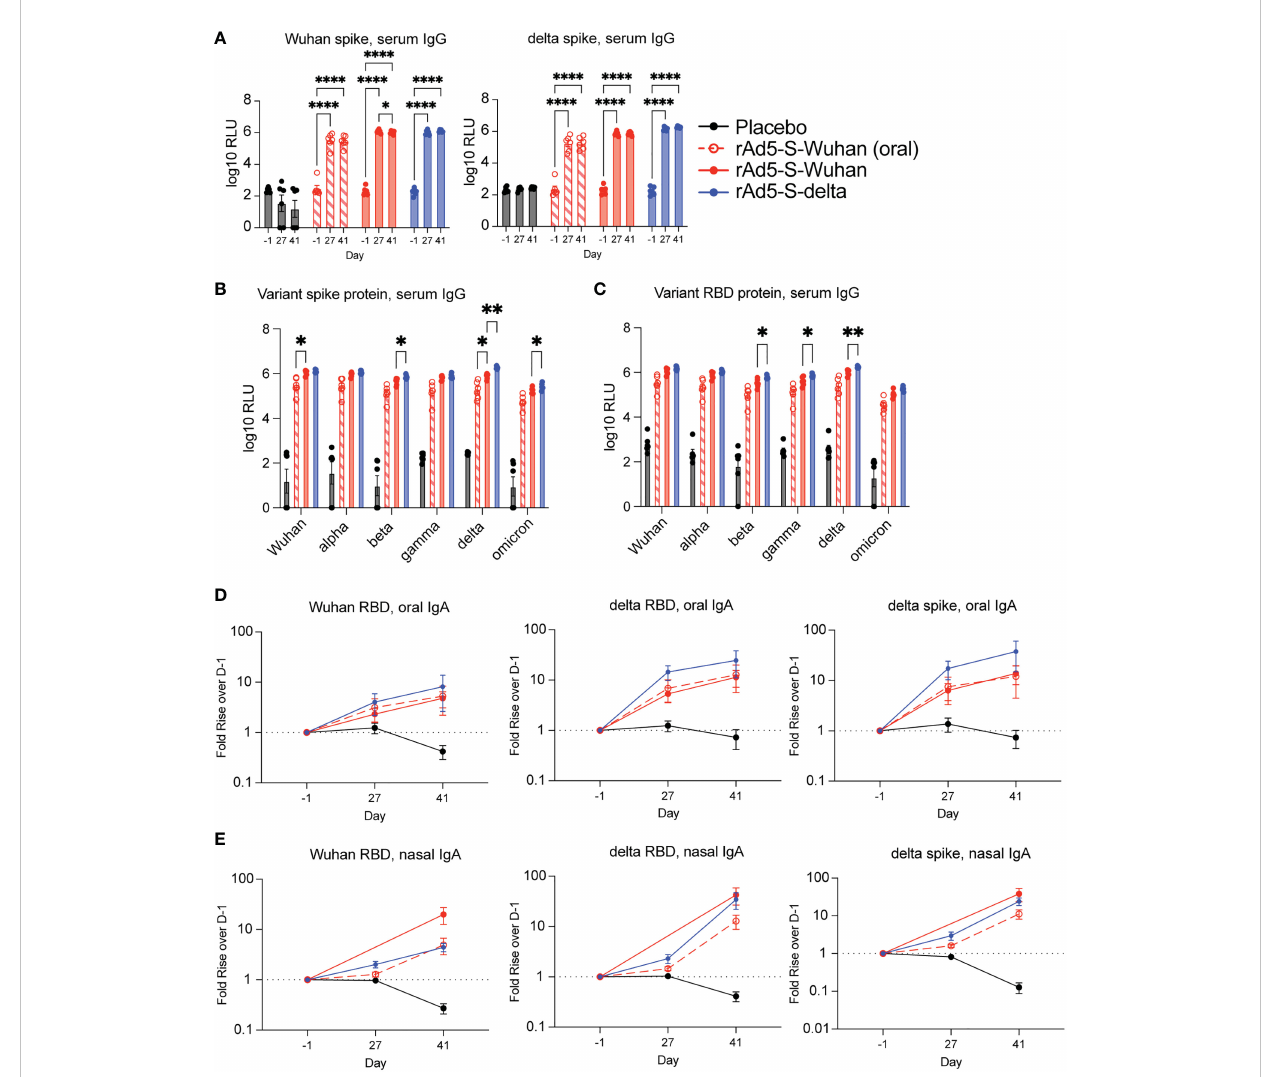
FIGURE 3 Serum and mucosal antibodies from Wuhan- and delta-based vaccination. (A) Serum IgG from hamsters vaccinated by oral gavage with rAd5-S- Wuhan (red – open shapes/dotted lines), intranasally with rAd5-S-Wuhan (red), rAd5-S-delta (blue), or placebo (black) prior to vaccination (D-1), prior to boost (D27) and two weeks after boost (D41). (B, C) Levels of serum IgG to spike (B) and RBD (C) of SARS-CoV-2 VOC at D41 post prime vaccination. (D) IgA from oral swab eluates and (E) nasal washes at indicated times. Antibody signals were normalized to total IgA and plotted as fold rise of D-1. Mean and SEM plotted. 2-way ANOVA with a Geisser-Greenhouse correction and with Tukey ’ s multiple comparison test. *p < 0.05, **p < 0.01, ****p <